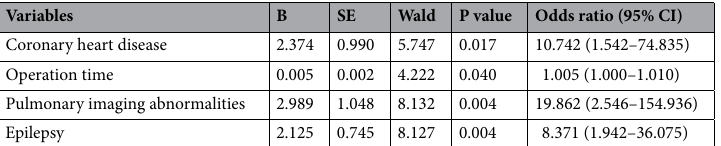
Table 6. Multivariate logistic regression analysis of risk factors influencing postoperative pneumonia in the patients underwent craniotomy for brain tumor. Adjusted for age, diabetes mellitus, postoperative albumin, operative time, intraoperative blood loss, renal failure. B regression coefficient, SE standard errors of regression